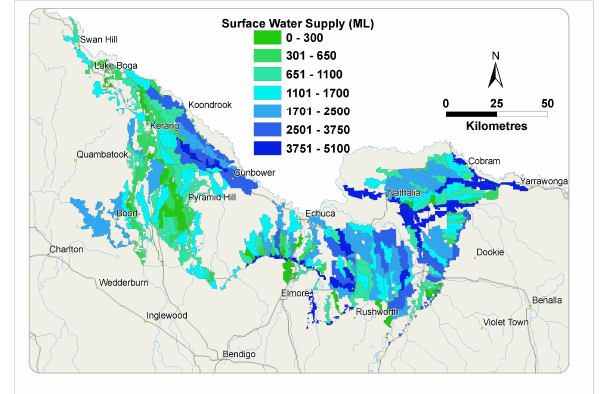
Figure 2. Total surface water (water supply) during January – April 2009 in Goulburn-Murray catchment.